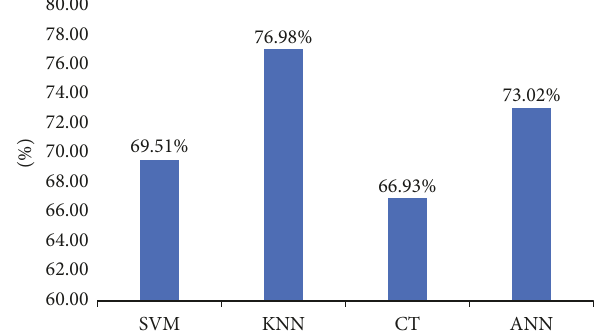
Figure 4: Average accuracy of classification on selected features.